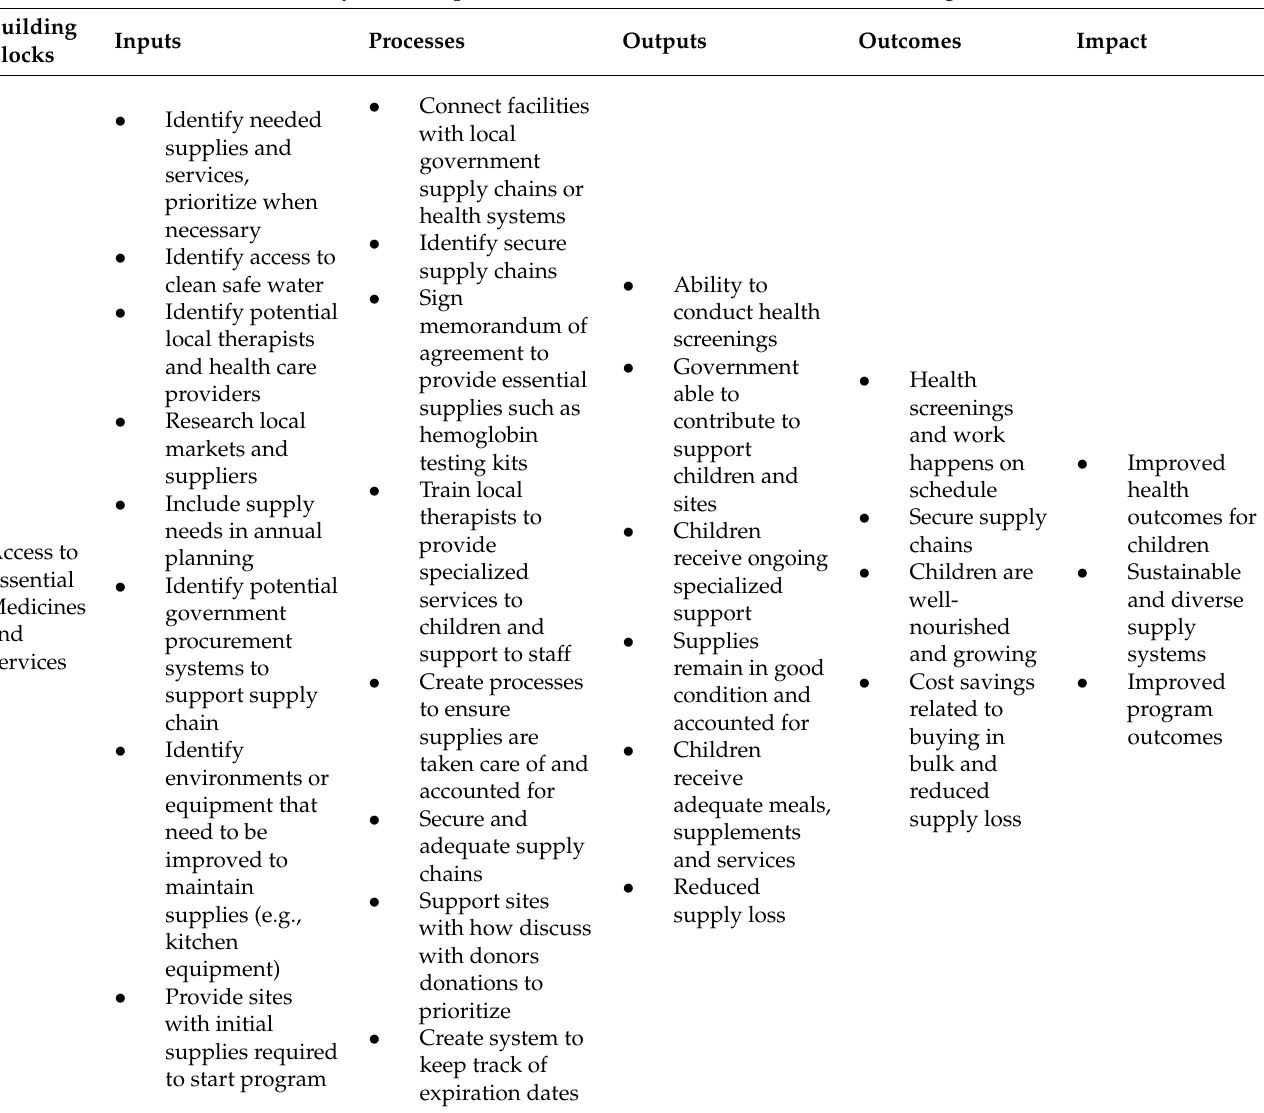
Table A3. Cont. Summary of the Implementation Process of the Child Nutrition